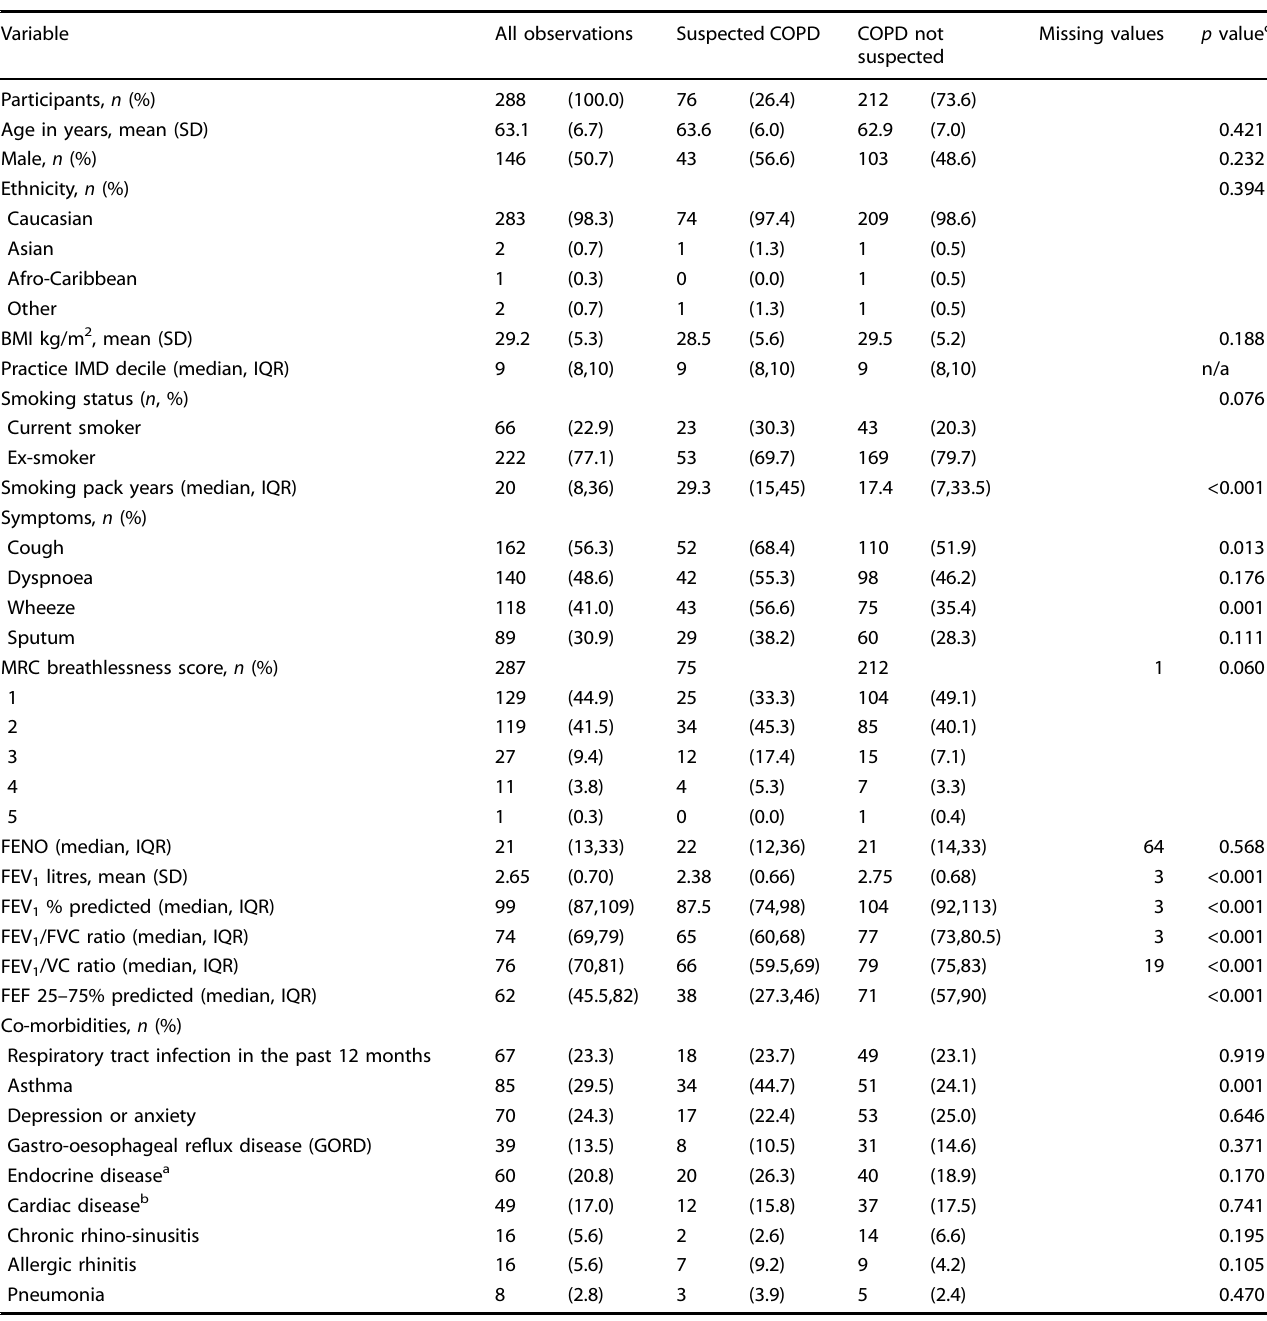
Table 1. Patient